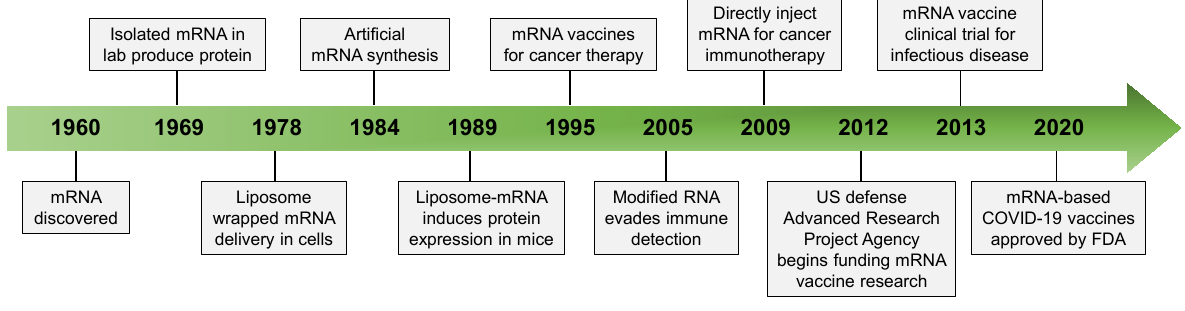
Figure 1. The development history of mRNA